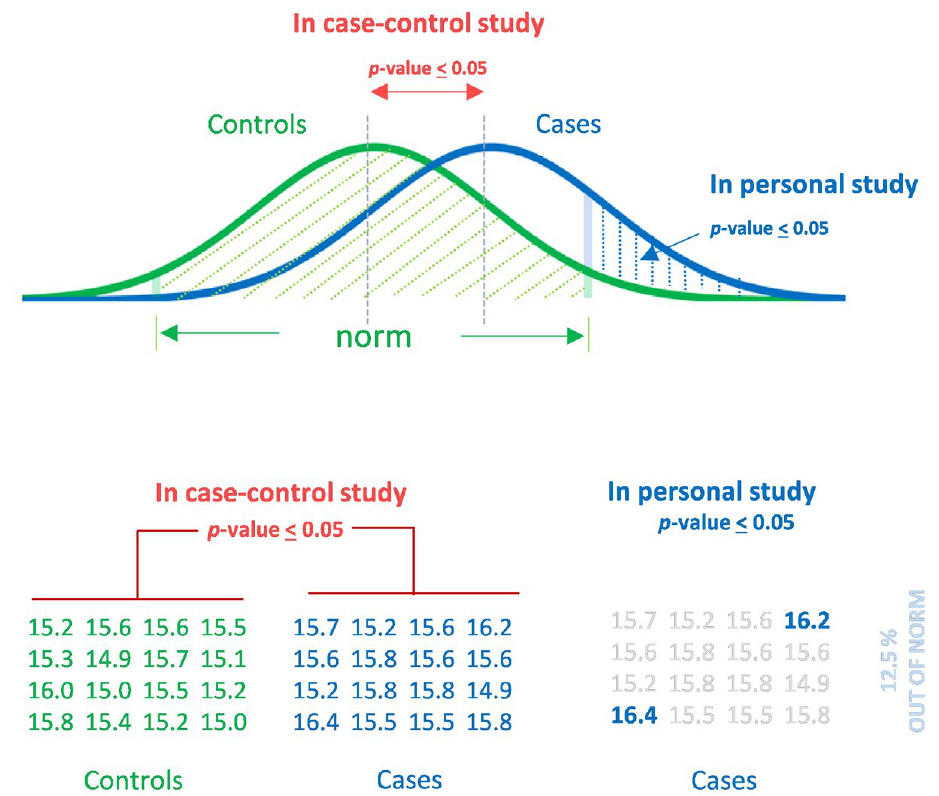
Figure 2. p -value-dependent challenge of personal metabolomics. A metabolite detected in a case– control metabolomic study as case-associated ( p < 0.05) is not considered out of the norm in a per- sonal metabolomics study. Case–control studies compare group characteristics. Individual (per- sonal) p -values will overwhelmingly fit within the normal values (e.g., at p < 0.05, only 12.5% of cases will be outside of the normal range).